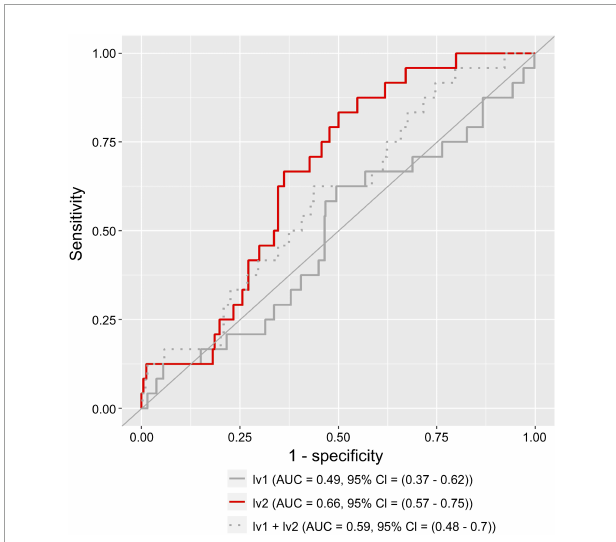
FIGURE6 Receiver operating characteristic (ROC) curve for a logistic regression model using lv1 or lv2 as the explanatory variables. The solid gray and red lines represent the results of the model with lv1 and lv2 as the explanatory variables, respectively. The dashed gray line represents the results of the model with both lv1 and lv2 as the explanatory variables. AUC represents the area under the curve, and a 95% CI represents the 95% confidence interval of the